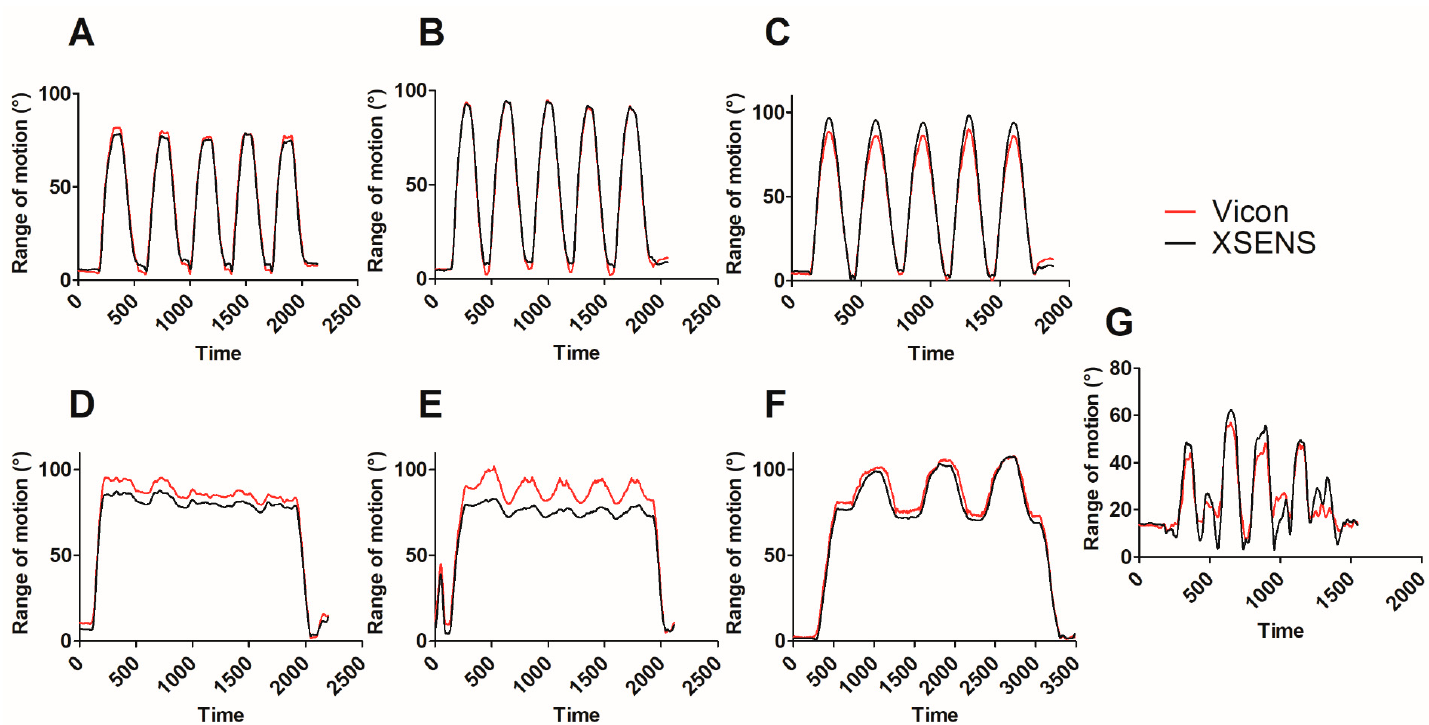
Figure 2. Kinematic pattern (range of motion) of a typical subject performing simple movements ( A : 90° shoulder flexion, B : 90° shoulder abduction, C : 90° shoulder scaption, D : 90° shoulder flexion combined to trunk flexion, E : 90° shoulder flexion combined to lateral trunk bending, F : 90° shoulder flexion combined to trunk rotation) and a complex task ( G : lifting and dropping of a crate on the medium shelf). Vicon kinematic pattern is traced in red and Xsens kinematic pattern is traced in black.